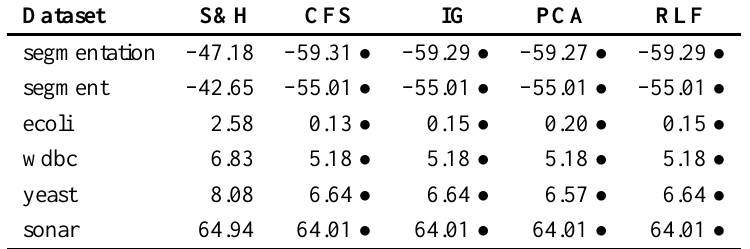
Table 6. Log-likelihood comparisons of feature-reduced hierarchical clusterer.